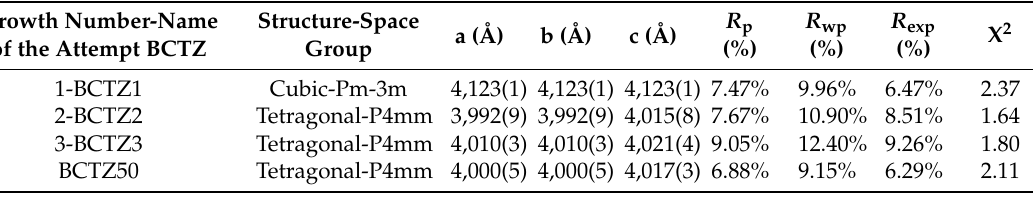
Table 5. Rietveld refinement for BCTZ crystals where a, b and c are lattice parameters and R p , R wp , R exp and X 2 are Rietveld reliability factors